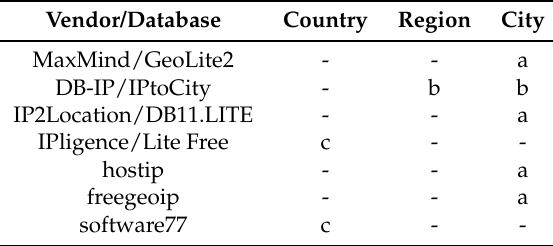
Table 4. Source of estimated device coordinates.